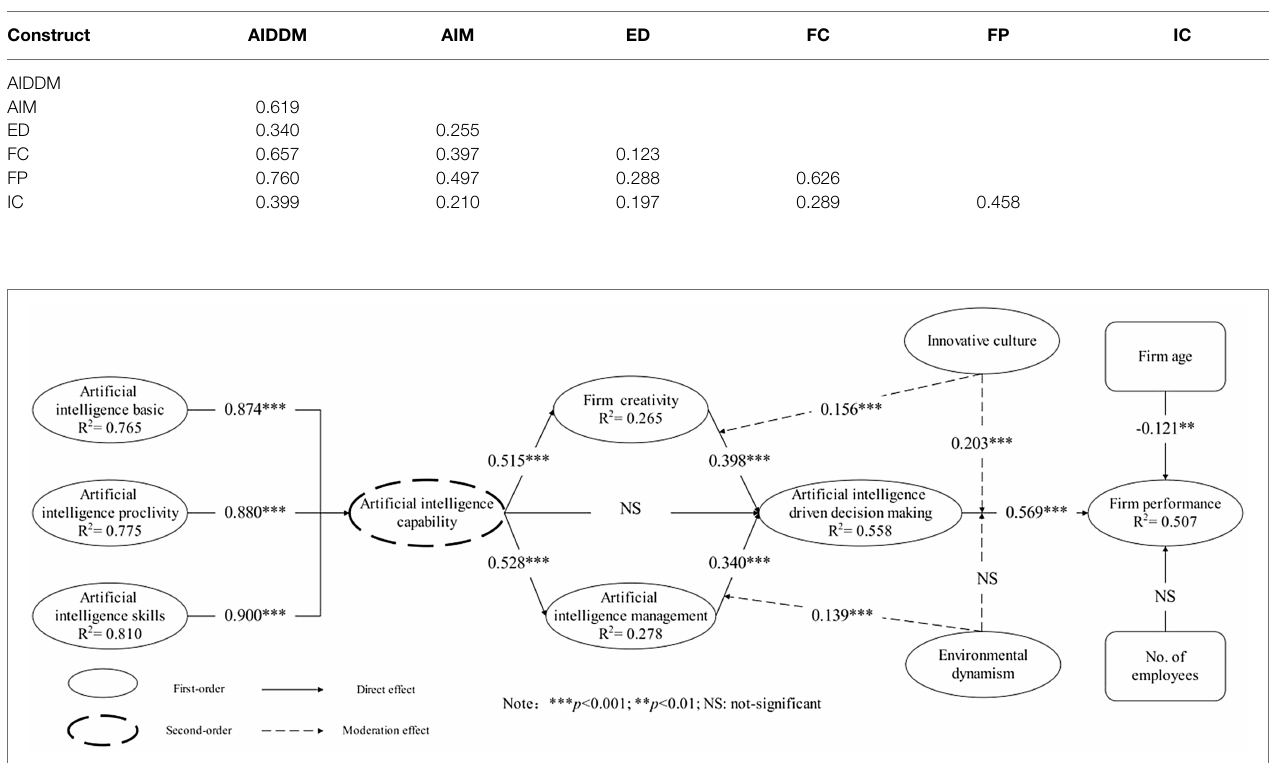
TABLE 6 | Assessment of discriminant validity using heterotrait-monotrait ratio (HTMT).